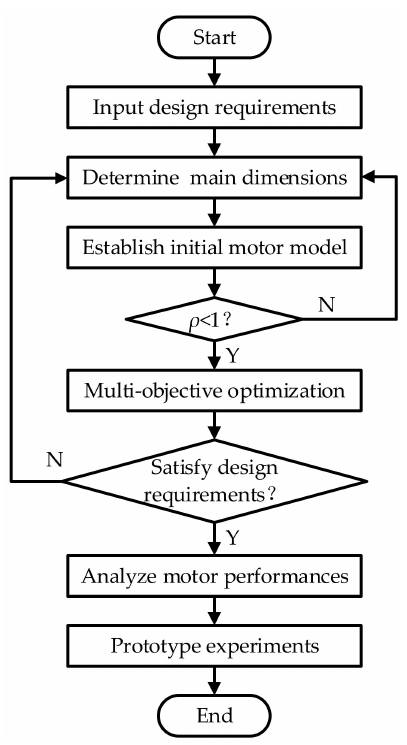
Figure 4. The optimization design flowchart for the